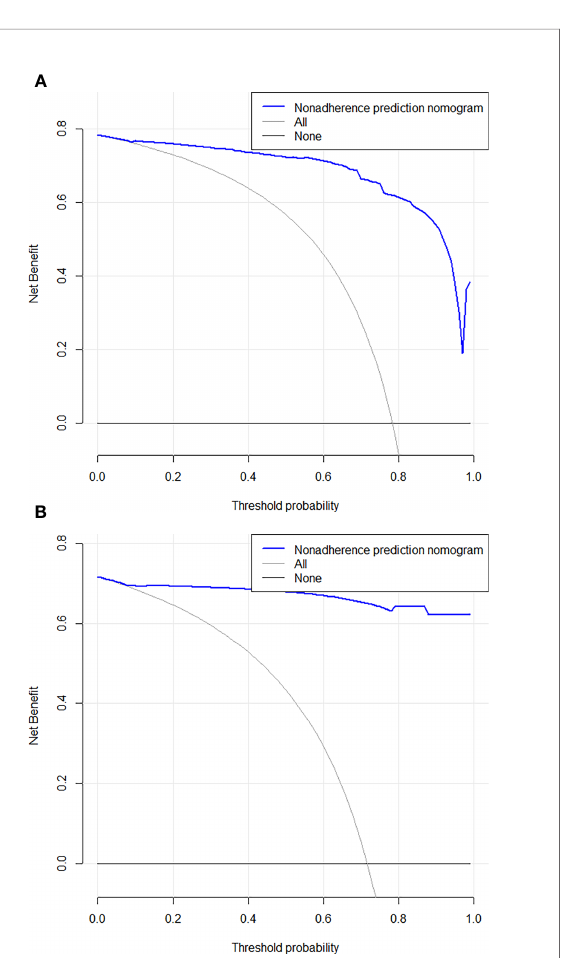
FIGURE 5 | Decision curve analysis for the combined nomogram in the training (A) and test (B) cohorts. The Y axis represents the net bene fi t, and the X axis represents the threshold probability. The solid blue line shows the expected net bene fi t per patient based on